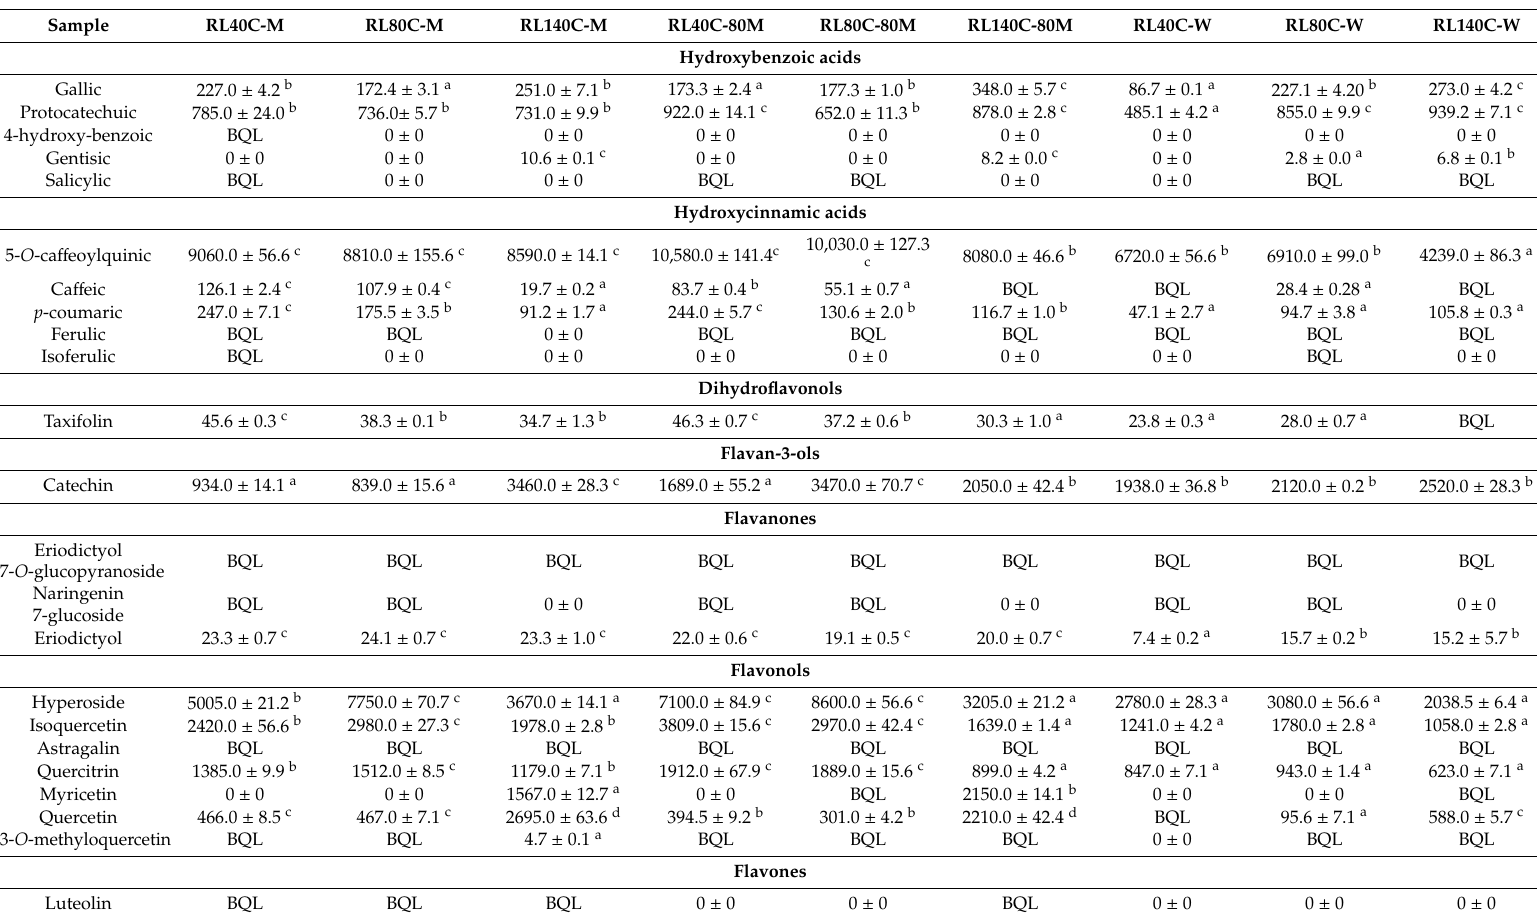
Table 2. Content of phenolic acids ( µ g / g of dry extract), flavonoid aglycons ( µ g / g of dry extract), and flavonoid glycosides ( µ g / g of dry extract) in di ff erent R. luteum extracts. Abbreviations as in Table